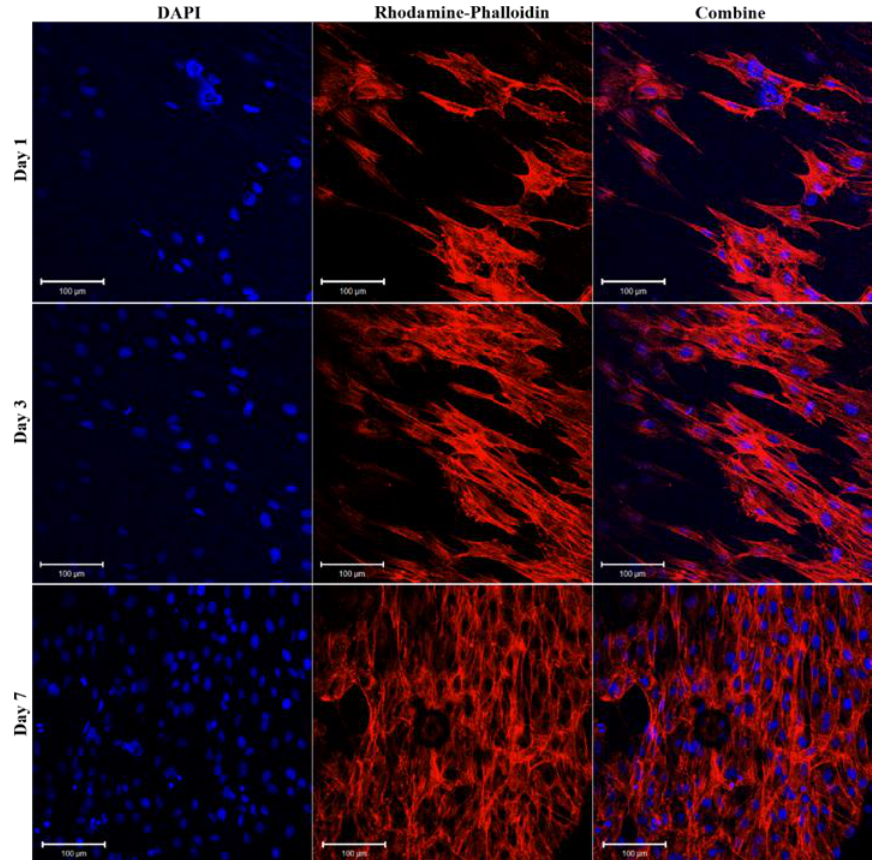
Figure 10. Fluorescent images of MC3T3-E1 pre-osteoblast cells attached on Mg-OH-AA-BSA scaffolds. The cells were cultured on the samples for (1, 3, and 7) days, separately. Nuclei and cytoplasm were stained by DAPI (blue) and Rhodamine–Phalloidin (red), respectively. (Scale bar = 100 µm).